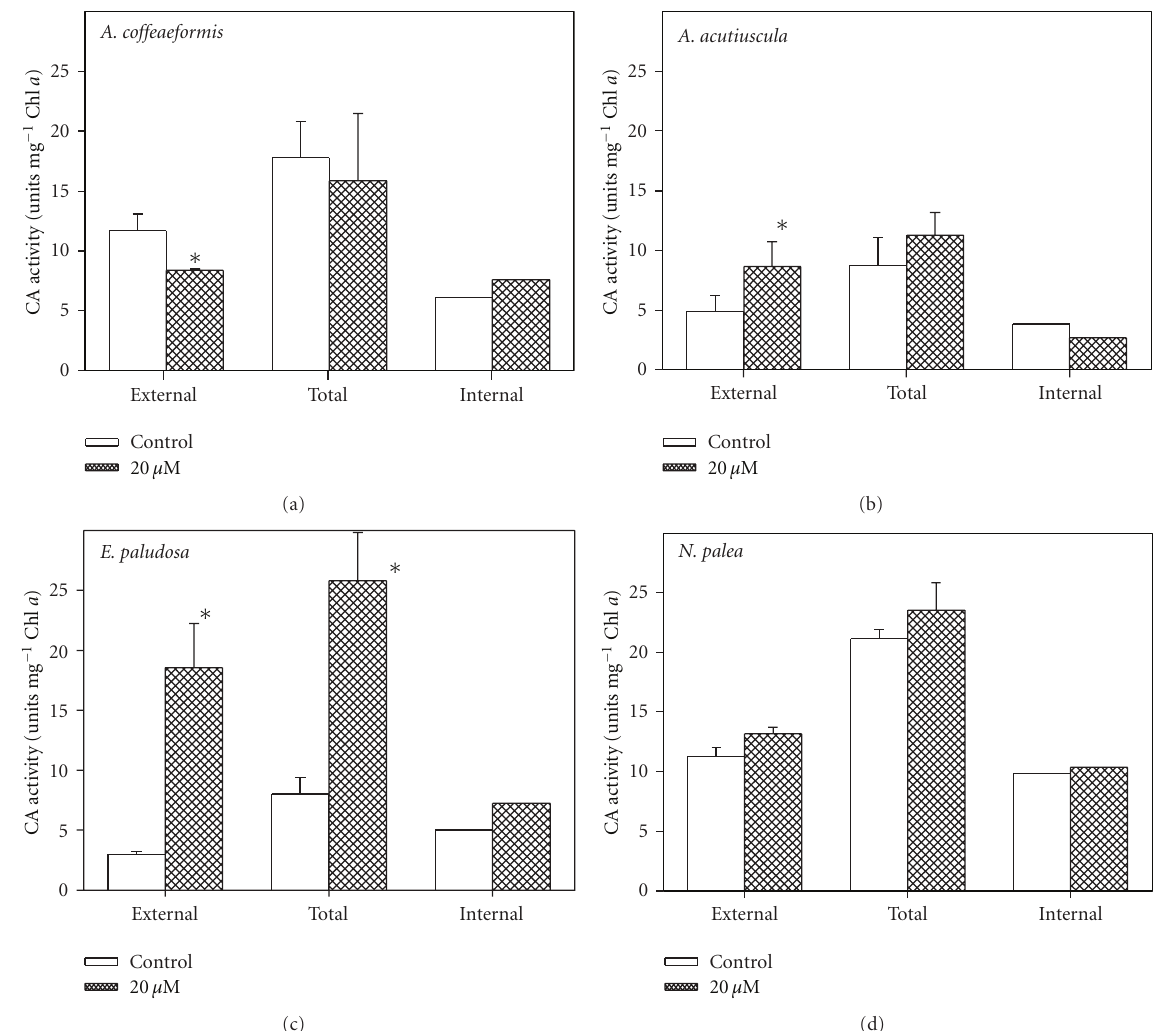
Figure 5: External, internal, and total carbonic anhydrase (CA) activities in Amphora co ff eaeformis, Amphora acutiuscula, Entomoneis paludosa, and Nitzschia palea grown in ASW (control) or in the presence of 20 μ M Zn added to ASW. Mean values ± SE ( n = 3–5). Significant di ff erences are indicated by an asterisk ( P ≤ 0 .